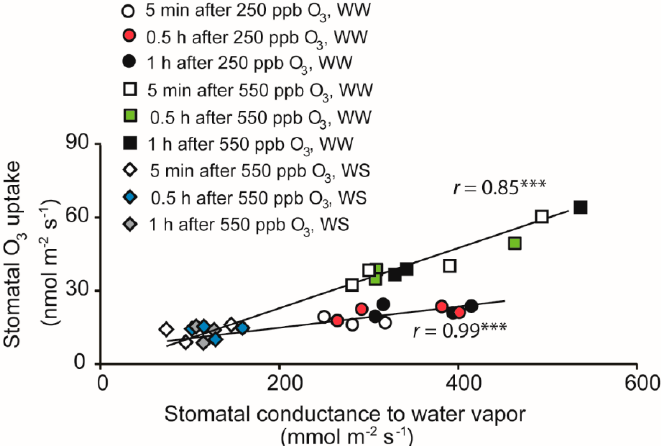
Figure 2. Relationships between stomatal conductance to water vapor and stomatal O 3 uptake rate in well-watered (WW) B. nigra plants treated with 250 or 550 ppb O 3 and water-stressed (WS) plants treated with 550 ppb O 3 measured at the beginning (~5 min), in the middle (0.5 h) and at the end (1 h) of the O 3 exposure. Linear regressions were statistically significant at p < 0.001 (***).